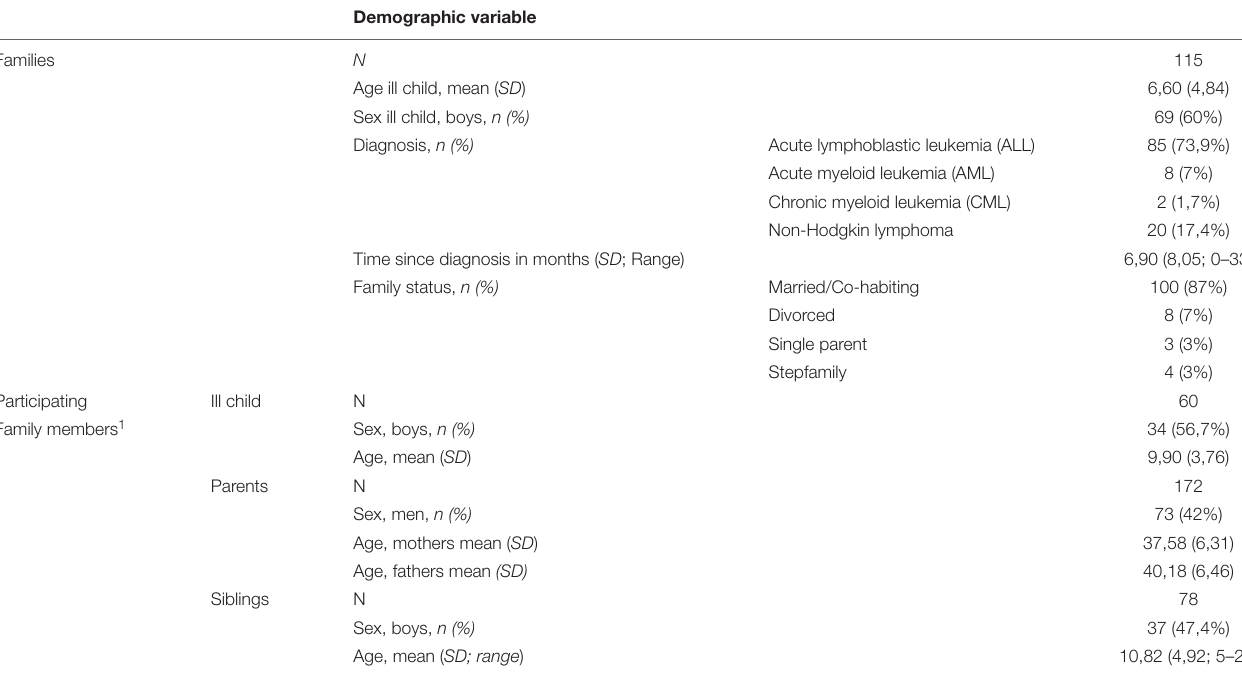
TABLE 1 | Background characteristics of the study